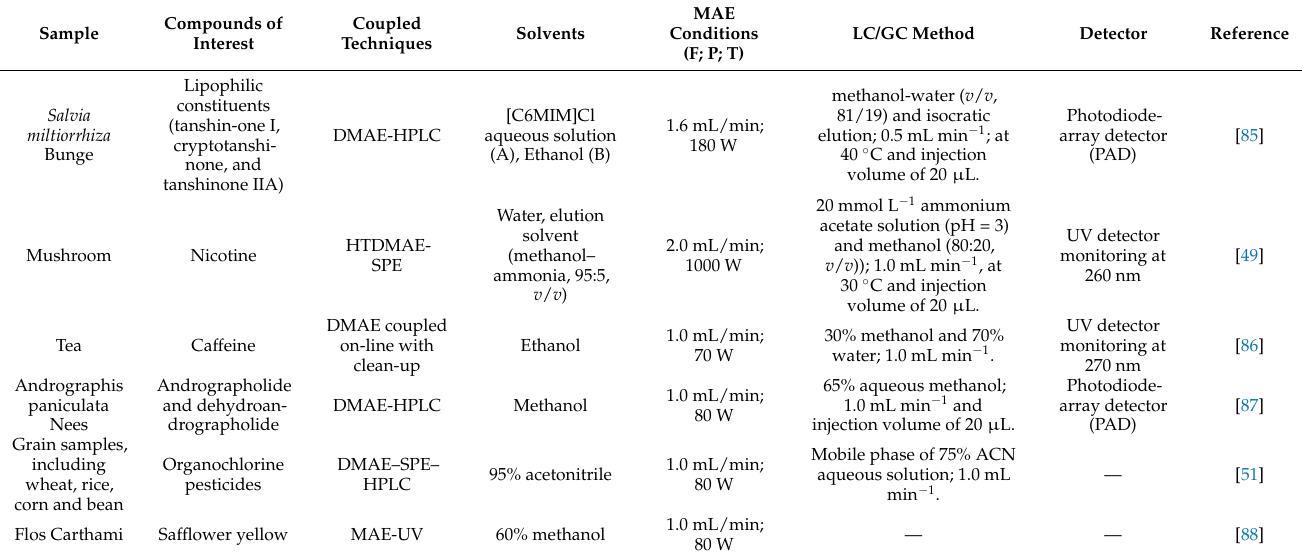
Table 6. Comprehensive report of MAE systems coupled with on-line analysis systems for solid matrices from vegetable